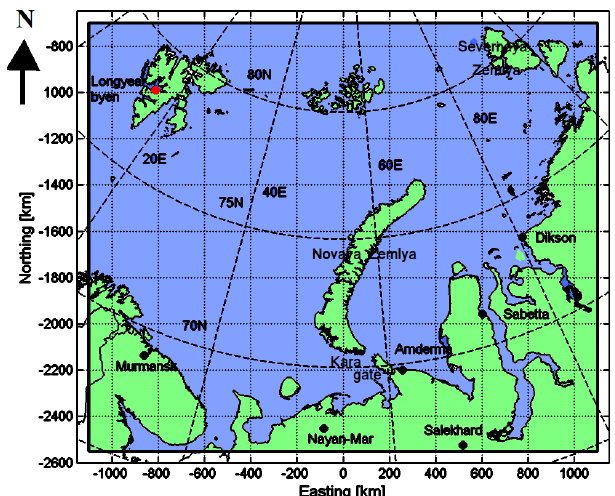
Figure 1. The study area in the used polar stereographic